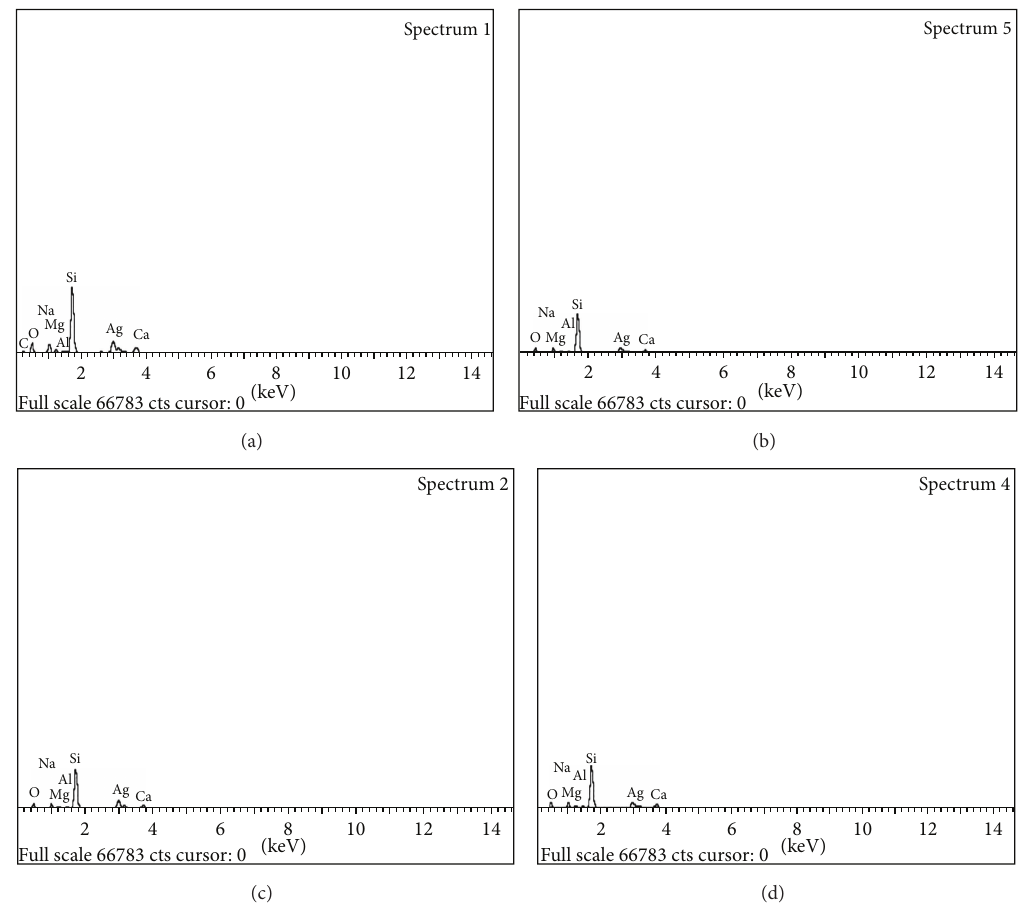
Figure 1: The EDS spectrum of Ag 𝑥 O deposited after (a) 60mins, (b) 70mins, (c) 80 mins, and (d) 90mins.